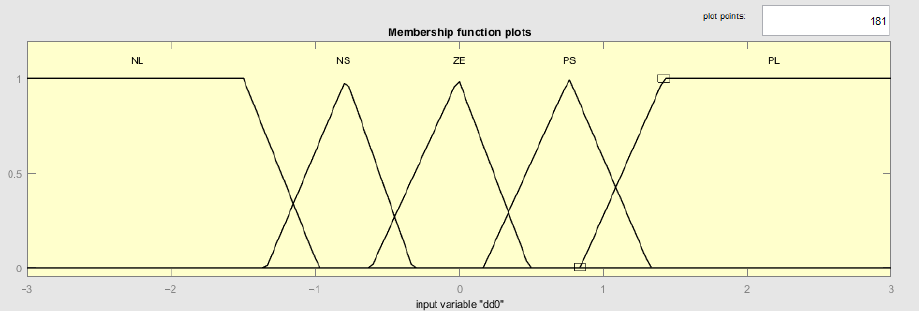
Figure 8. Membership function of the input value “power deviation”.